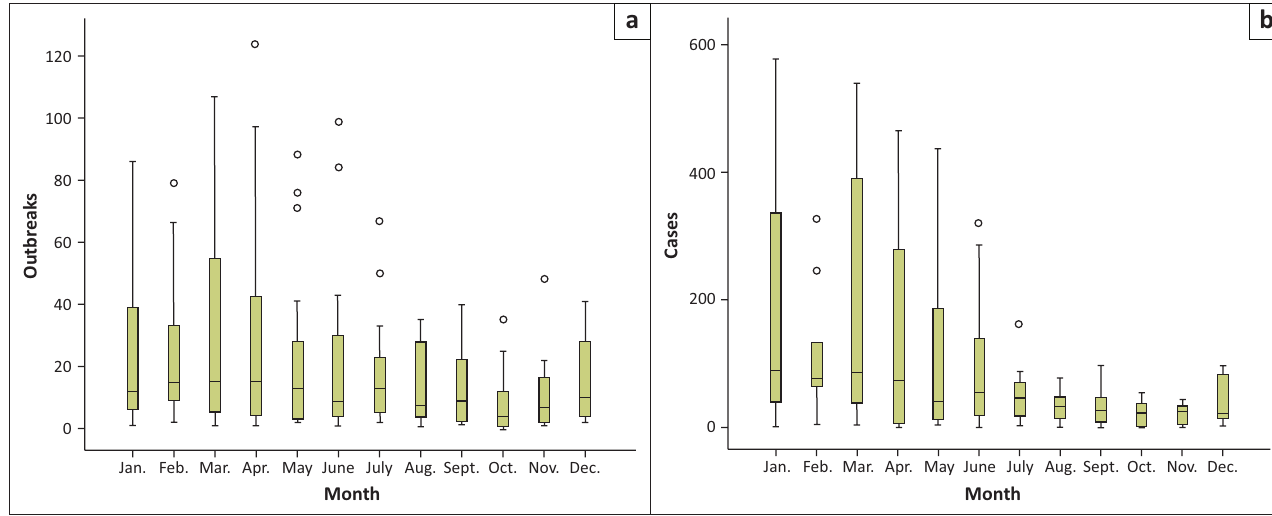
FIGURE 1: Monthly distribution of dermatophilosis (a) outbreaks and (b) cases for the period 1995–2014.